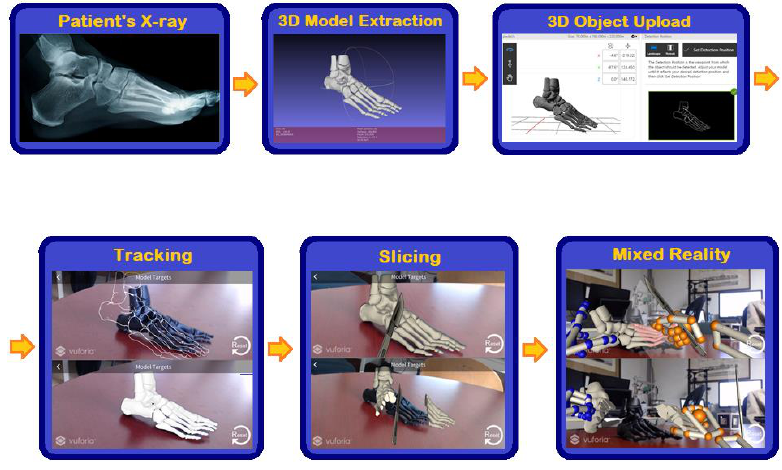
Figure 1. Methodology steps .